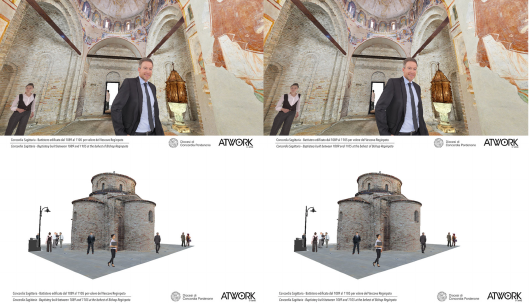
Figure 14. Stereoscopic images created by regular